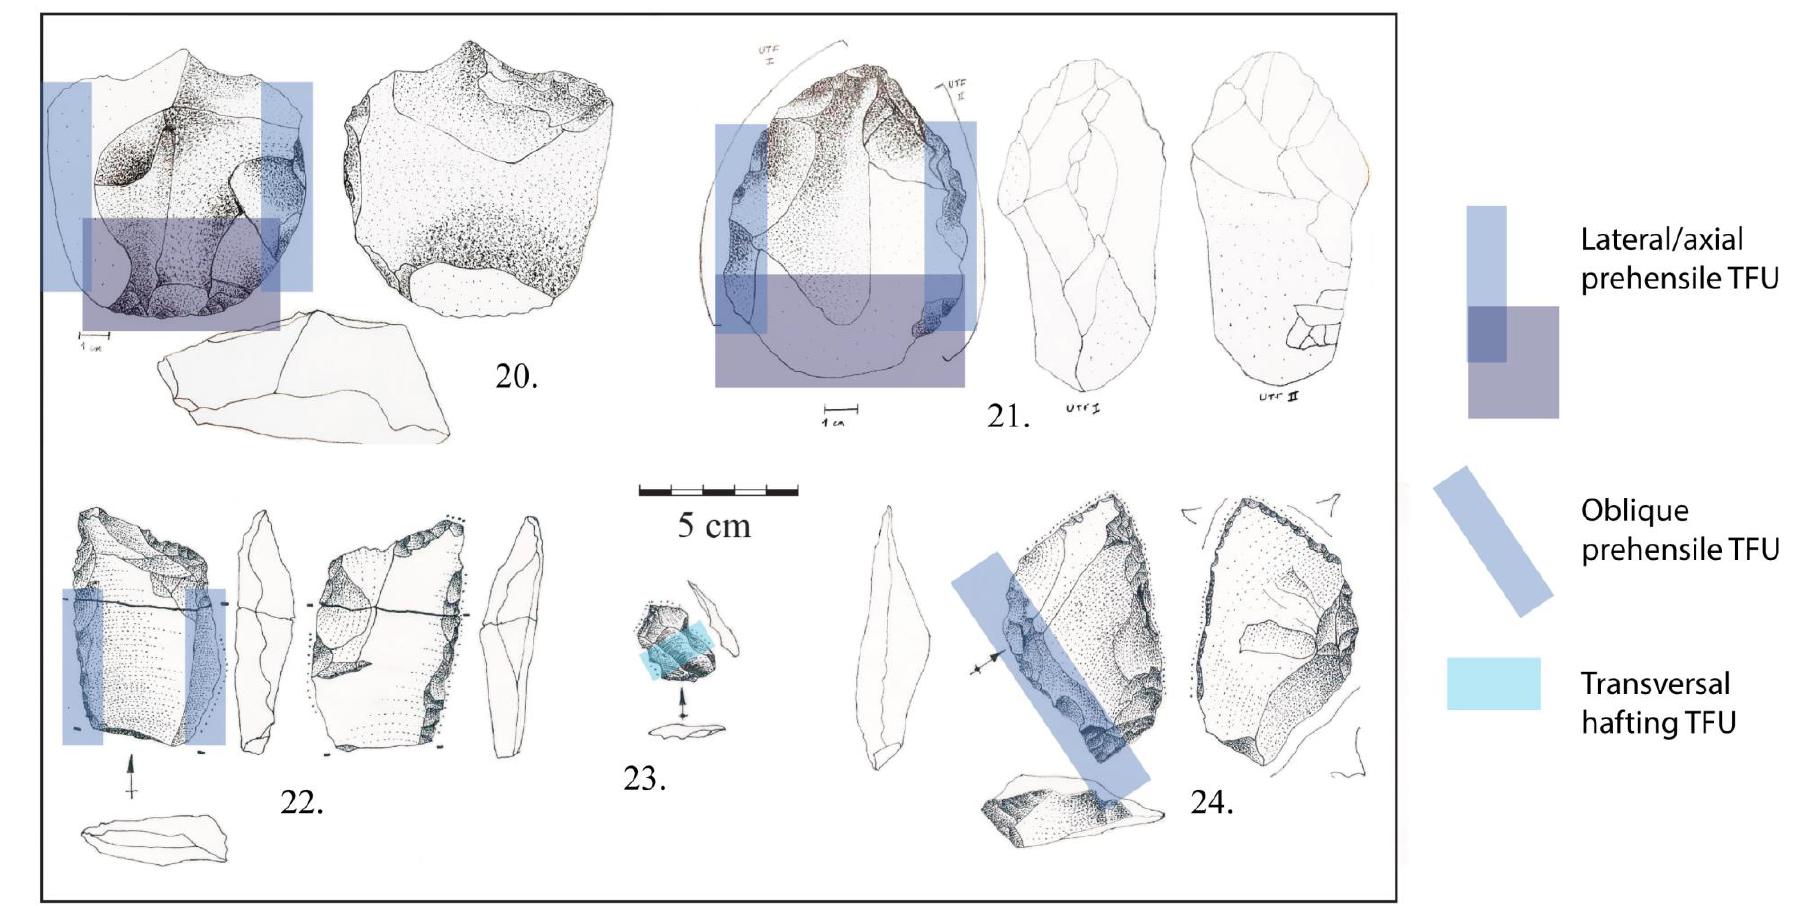
Figure 7. Different tools and their prehensile modes in Morro